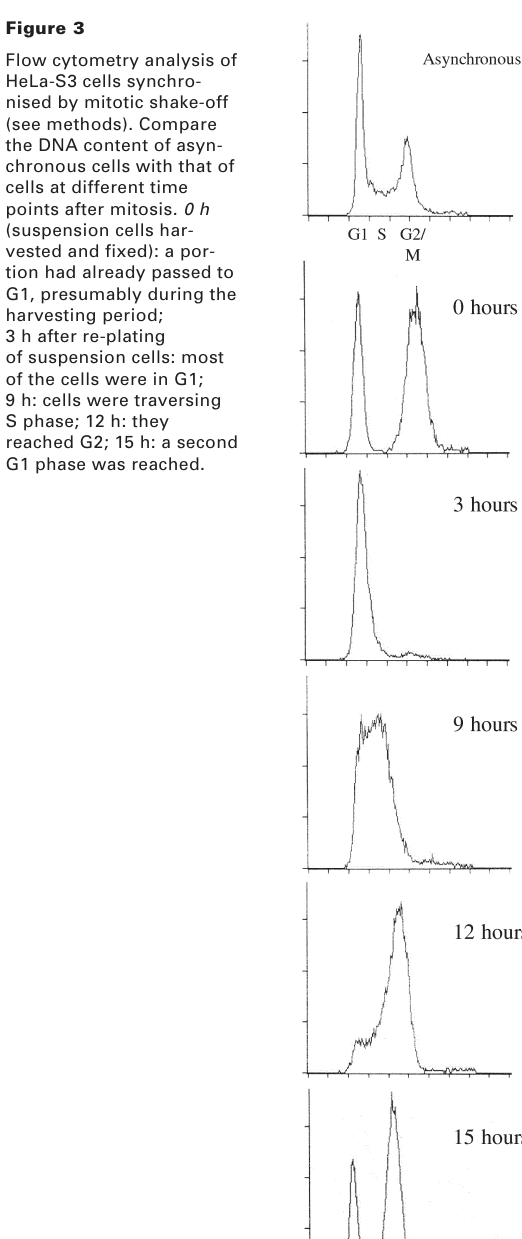
Flow cytometry analysis of HeLa-S3 cells synchro- nised by mitotic shake-off (see methods). Compare the DNA content of asyn- chronous cells with that of cells at different time points after mitosis. 0